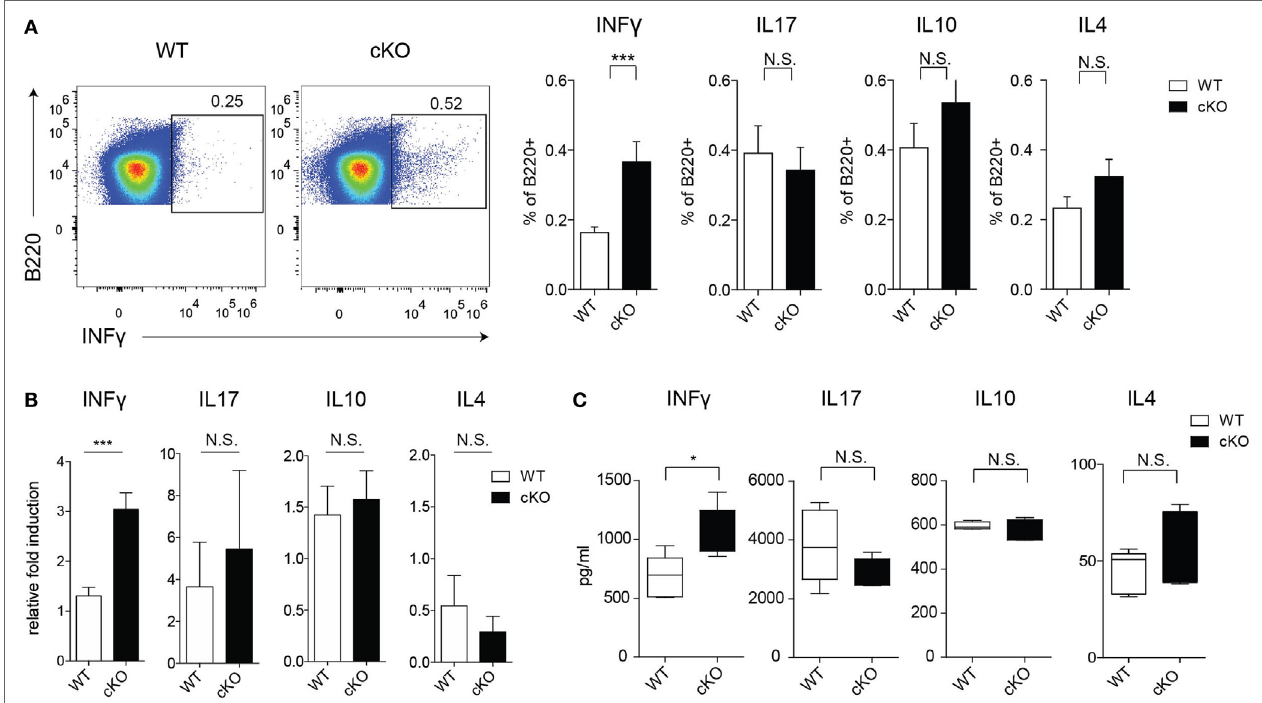
FigUre 2 | Lack of glucocorticoid-induced leucine zipper (GILZ) in B cells leads to increased production of IFN- γ in splenic B cells. (a) Flow cytometry analysis of IFN- γ , interleukin (IL)-17, IL-10, and IL-4 ex vivo production by B220 + cells in the spleen of wild-type (WT) and gilz B cKO mice. Plots in the left panels are representative of flow cytometry analysis of IFN- γ production by B220 + cells. (B) Quantitative real-time PCR analysis of cytokine produced by B220 + cells purified from spleen tissue stimulated in vitro with phorbol 12-myristate 13-acetate/ionomycin and lipopolysaccharide for 24 h. Data are derived from three independent experiments. (c) Concentration of IFN- γ , IL-17, IL-10, and IL-4 measured by enzyme-linked immunosorbent assay in sera of 9- to 12-month-old WT and gilz B cKO mice ( n = 7, 7). N.S., not significant; statistical analysis was performed using the unpaired Student’s t -test (* p < 0.05, *** p <